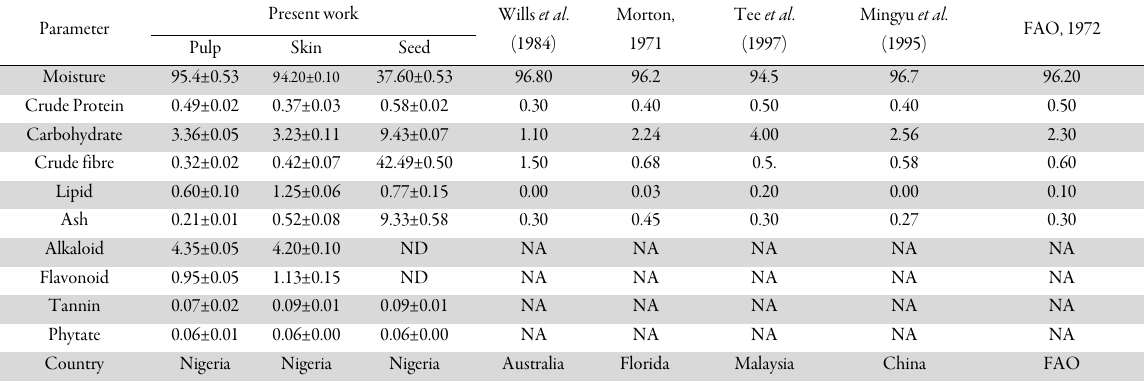
Table 3. Proximate and phytochemical composition of mature B. hispida (g/100g) Present work Wills et al Parameter